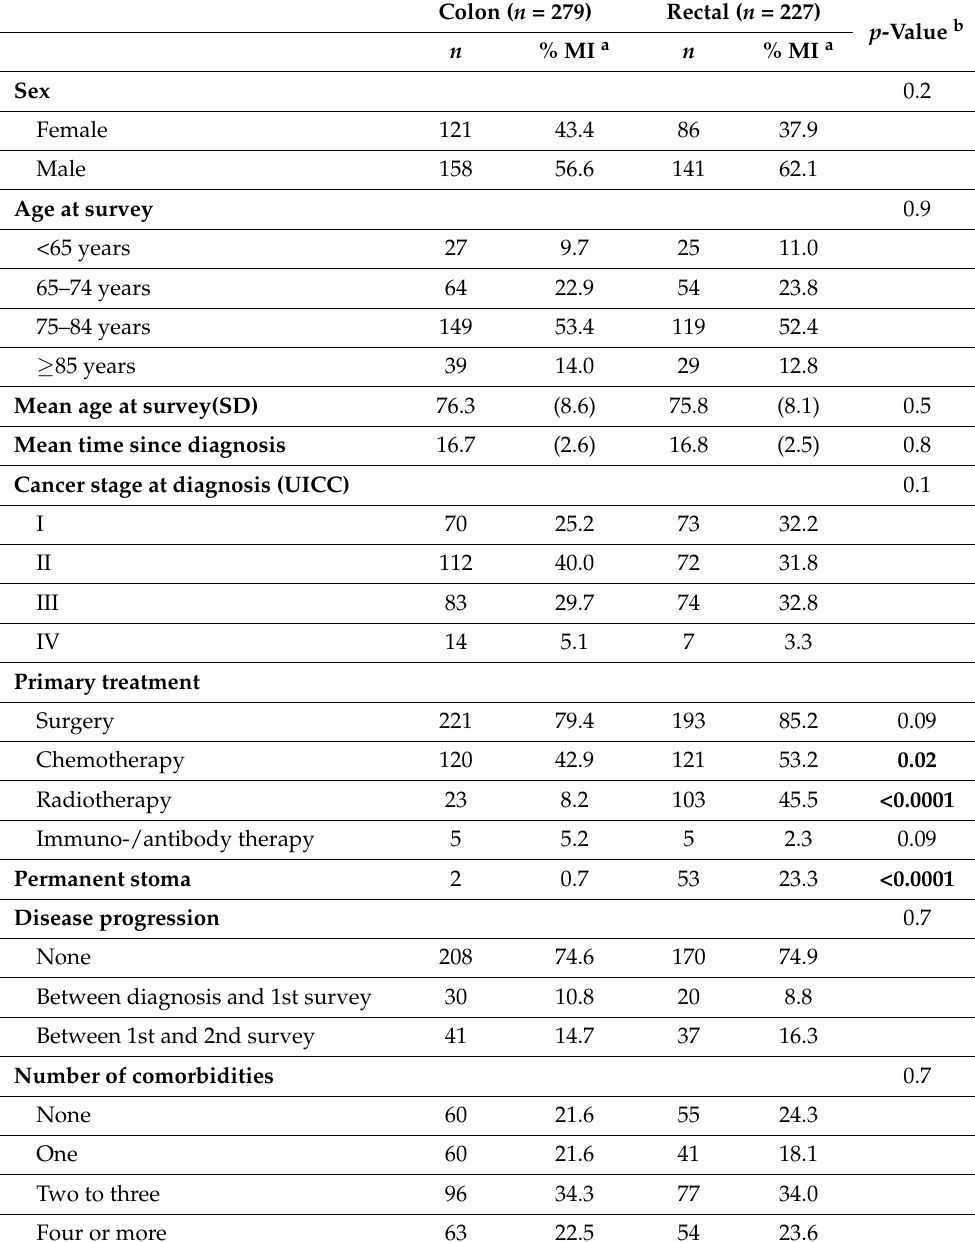
Table 3. Characteristics of cancer survivors by cancer